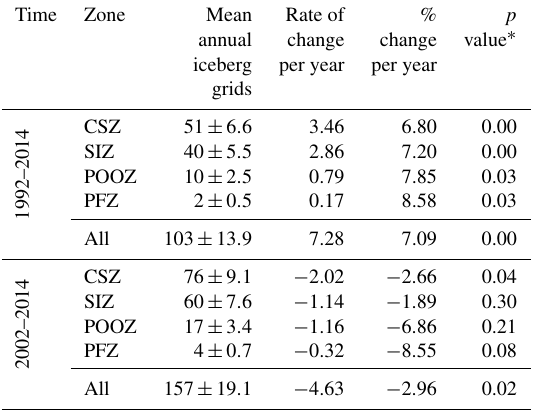
Figure 9. Temporal trend of total annual primary production by sec- tions in the